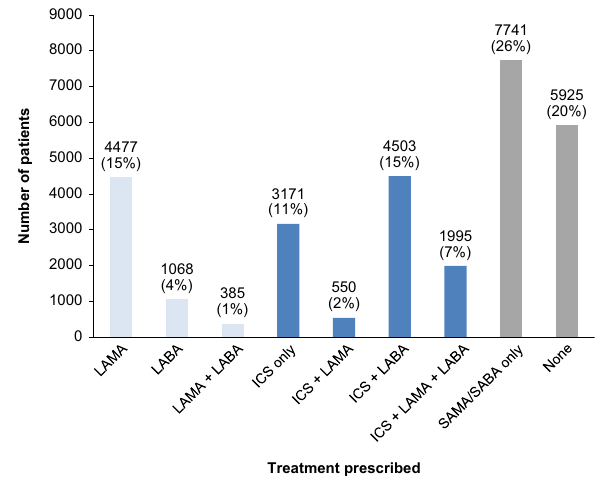
Fig. 1 Number of patients by therapy combination at COPD diagnosis (overall cohort). COPD chronic obstructive pulmonary disease, ICS inhaled corticosteroids, LABA long-acting beta-agonists, LAMA long-acting muscarinic antagonists, SABA short-acting beta- agonists, SAMA short-acting muscarinic antagonists